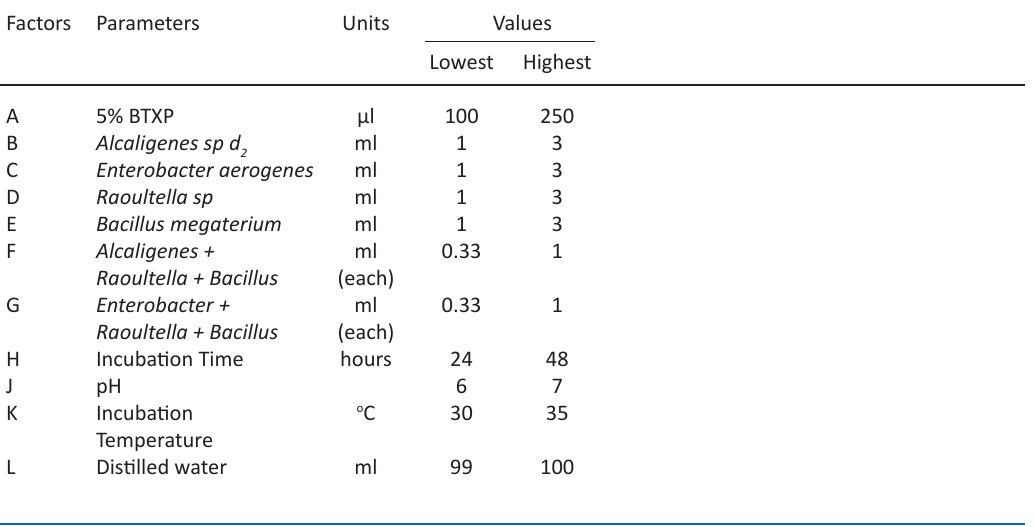
Table 1. The selected parameters and their value applied in the Plackett-Burman model for process optimization Factors